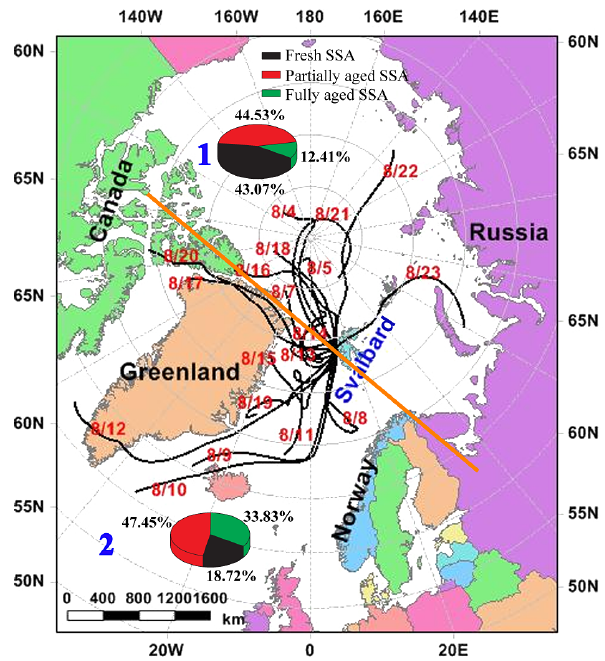
Figure 6. 72h back trajectories of air masses at 500m over Arctic Yellow River Station in Svalbard during 3–23 August 2012, and arriving time was set according to the sampling time. Air masses were divided into two groups by the yellow line: one group from the central Arctic Ocean and the other one from North America and Greenland. Pie charts show the number fractions of the fresh, partially aged, and fully aged SSA.